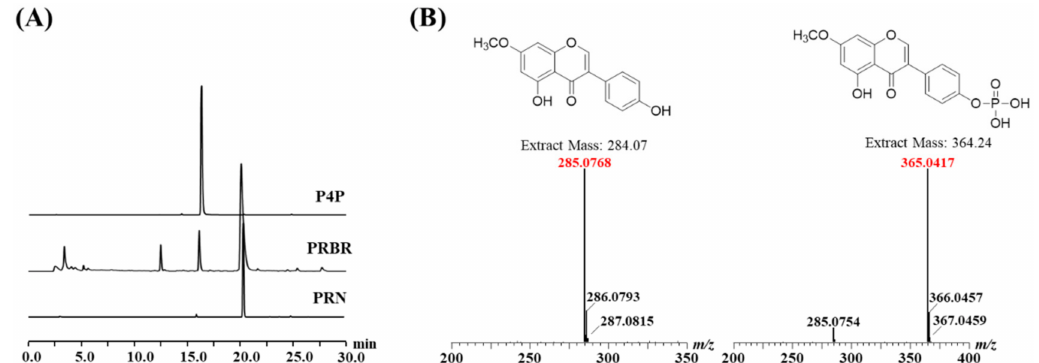
Figure 1. ( A ) HPLC analysis of prunetin (PRN) and the biorenovation products of prunetin (PRBR) and prunetin 4 (cid:48) - O - phosphate (P4P). ( B ) Mass analysis of PRN and